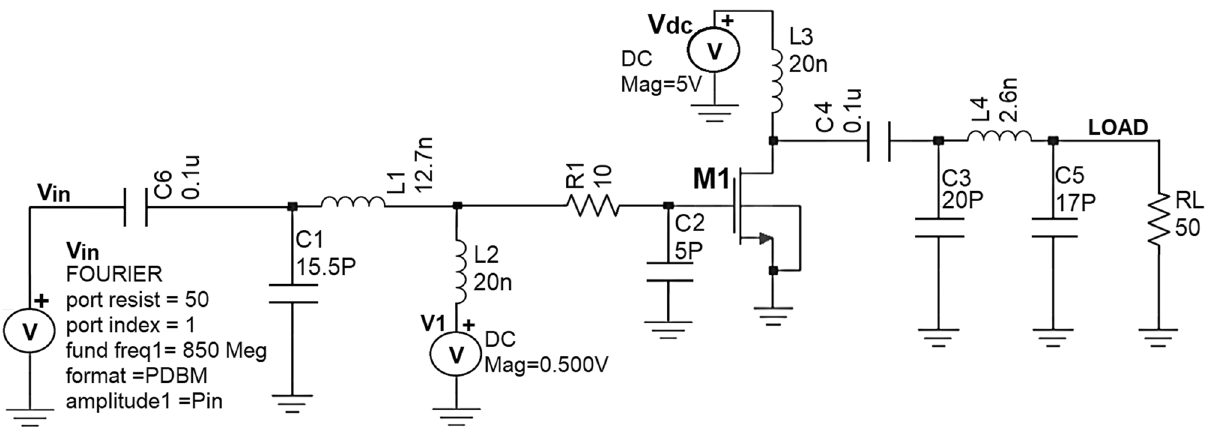
Figure 11. Schematic circuit of the Class J PA with Fourier input source at 850